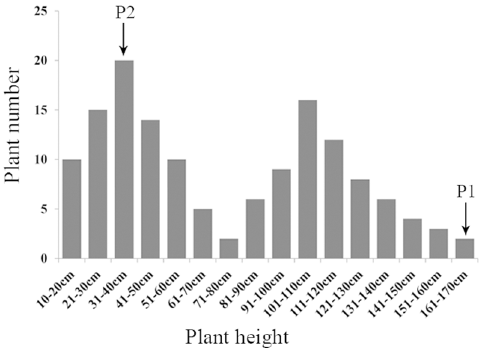
Fig 3. The frequency distribution of plant height in the F 1 population and the parent lines. P1 represents the female parent and P2 represents the male parent.